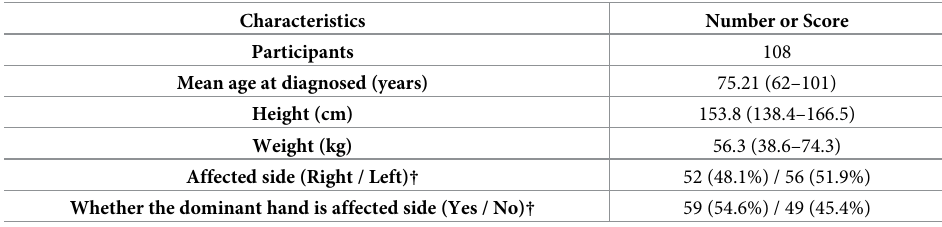
Table 1. Demographic characteristics of the